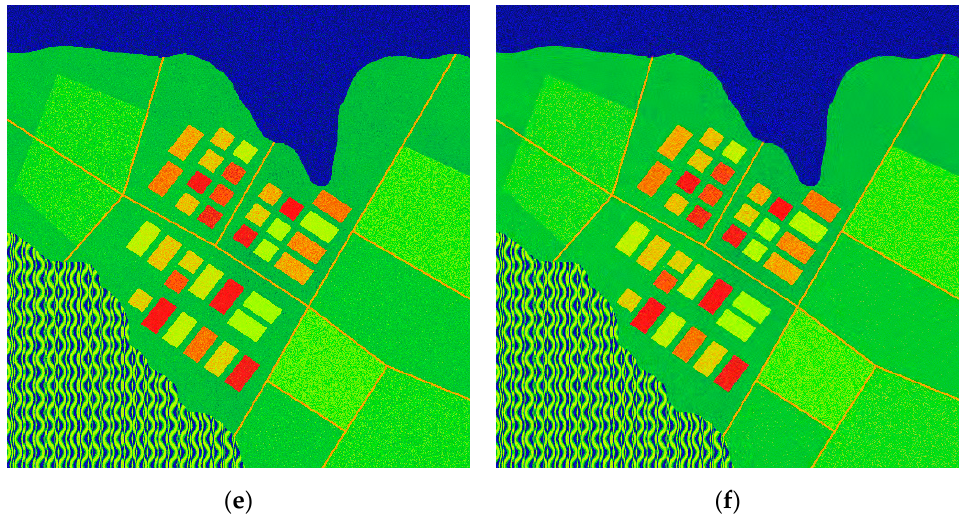
Figure 2. Three-channel test image: original ( a ), its three components ( b – d ), compressed with